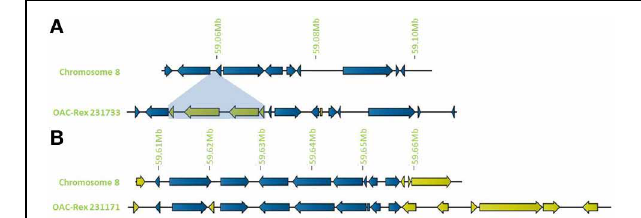
FIGURE 4 | Distribution of unique genes in G19833 and OAC-Rex. (A) Comparison of chromosome 8 showing the insertion of a cluster of unique genes around 59.06 Mb and a single unique gene at 59.08Mb. (B) Comparison of a section of chromosome 8 showing positions of unique genes in G19833 and OAC-Rex at the end of chromosome 8. Unique gene clusters in both G19833 and the OAC-Rex contig 231171 were found, with 3 unique genes and 6 unique genes,